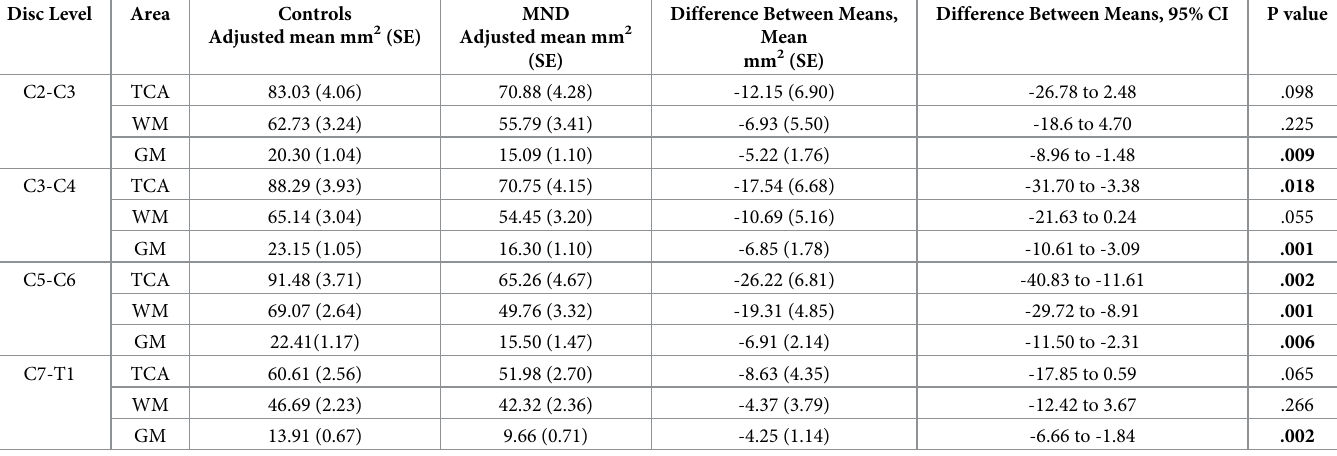
Table 5. Comparison of PSIR measurements for total cord, spinal cord gray and white matter areas (mm 2 ) between healthy controls and motor neuron disease patients (MND). Disc